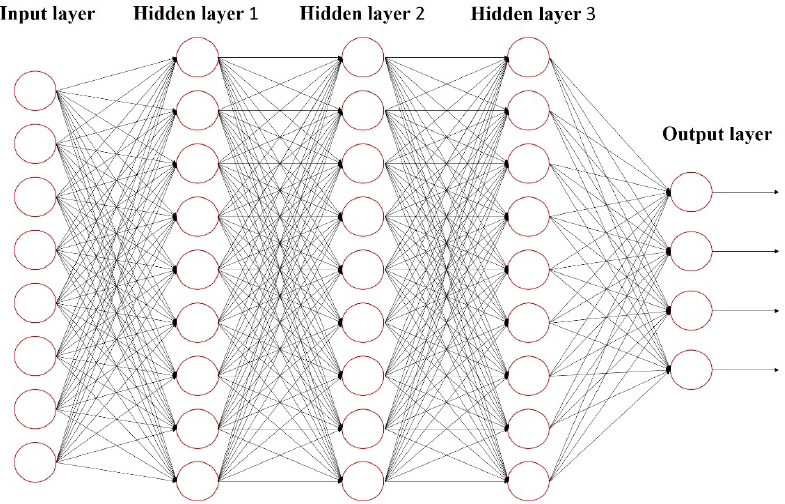
Figure 5. Deep neural network, DNN